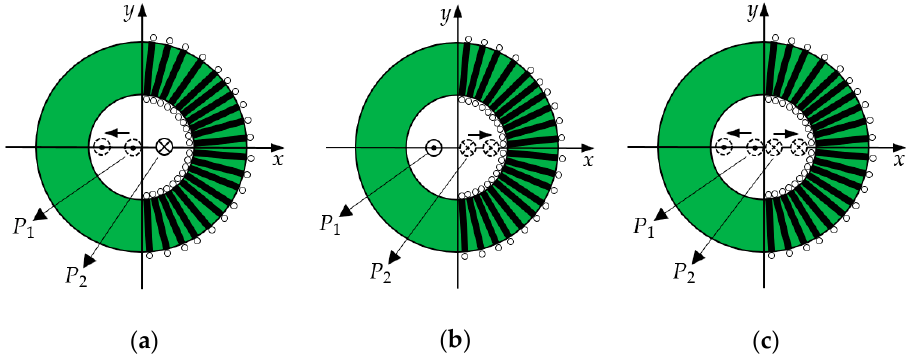
Figure 13. Schematic diagrams of eccentricity changes: ( a ) Case 1; ( b ) Case 2; and ( c ) Case 3.